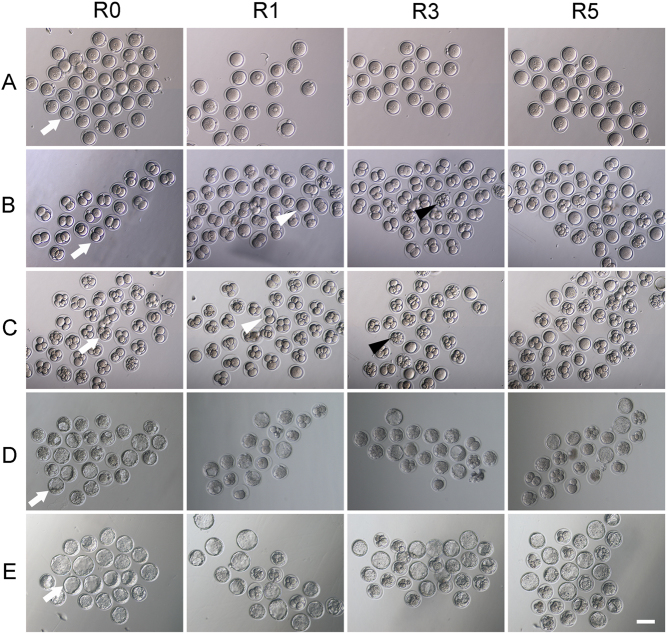
Representative images of in vitro-cultured embryos. Embryonic morphology images were acquired at 8, 24, 48, 84 and 108 h of culture. (A) Prokaryotic embryos at the PN4 phase; (B) two-cell stage embryos; (C) four-cell stage embryos; (D and E) blastocysts at 84 h and 108 h. Arrow indicates normal embryos at different stages, black arrowhead indicates dead embryos and white arrowhead refers to the blocked embryos. Scale bars = 100 μm.